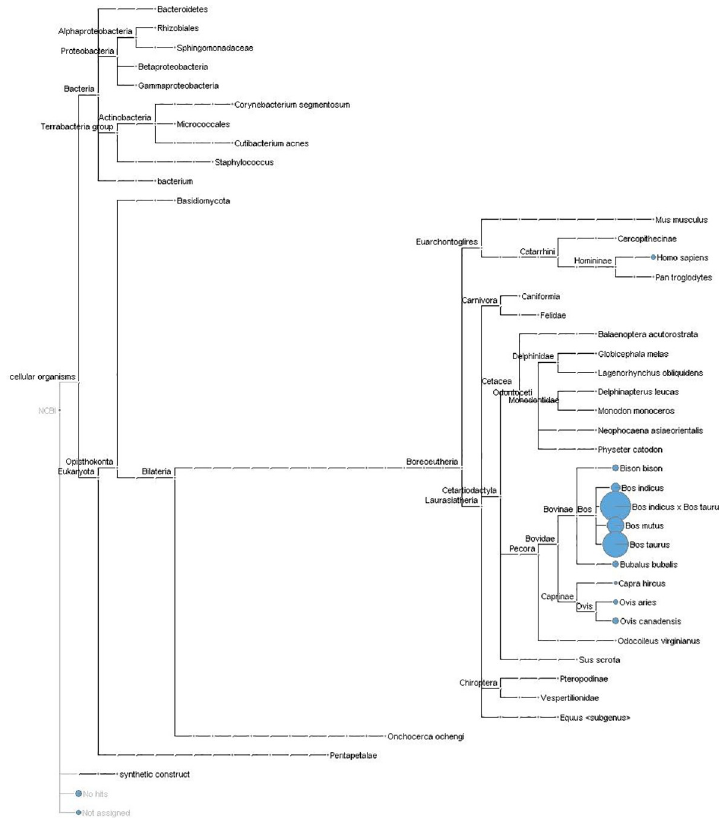
Fig 5. Phylogenetic map of de novo constructed contigs. Phylogenetic mapping of de novo assembled contigs with associated number of top hit alignments for each organism. The majority of alignments were seen with non- ARS-UCD1.2 Bos taurus , Bos indicus , and various ungulate assemblies. Assigned alignments are ordered within the phylogenetic tree, with a representative circle (in blue) based on the percentage of hits.